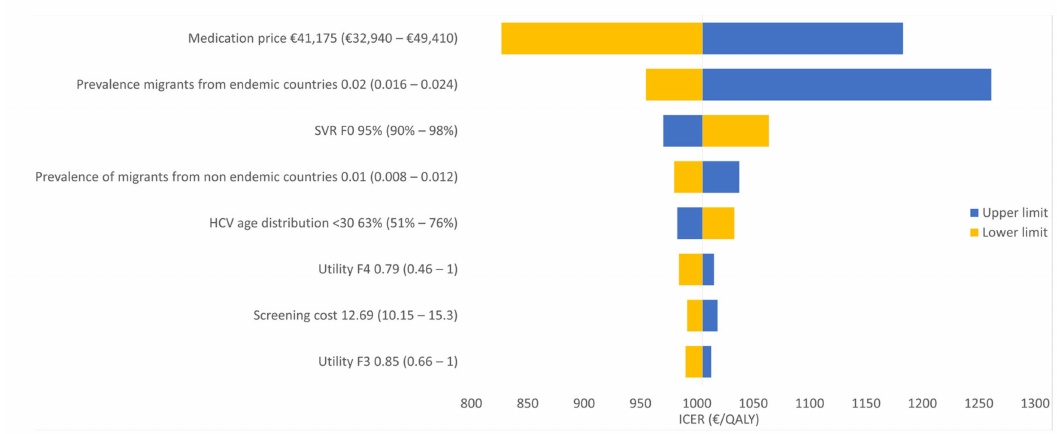
Figure 3. One-way sensitivity analysis for the (iii) HCV screening of all migrants strategy versus the (ii) screening of migrants from HCV-endemic countries strategy.